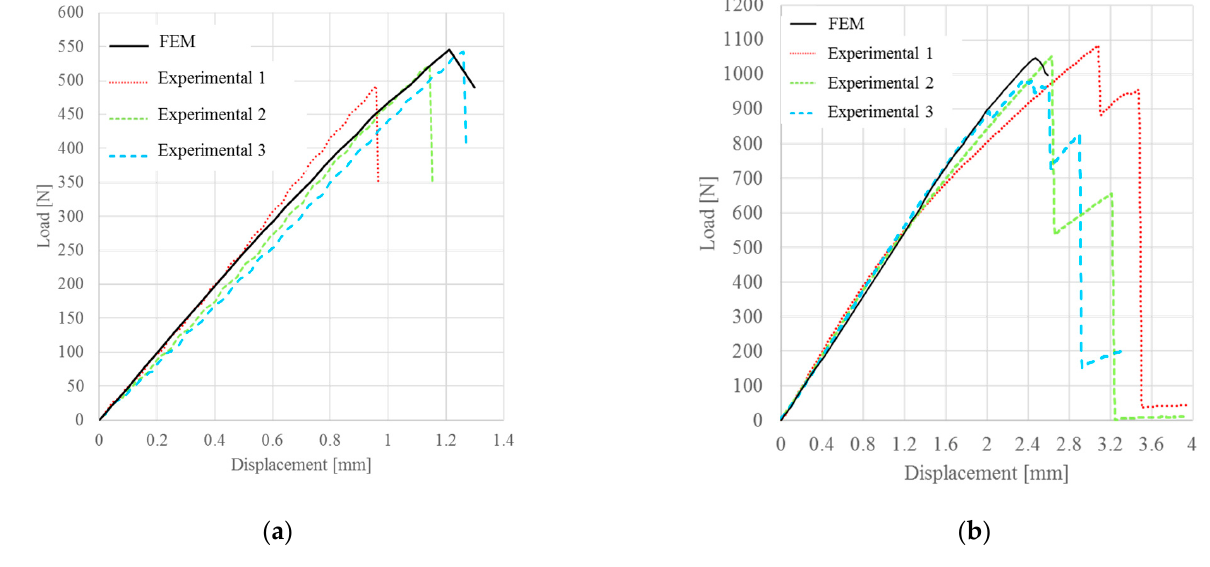
Figure 8. Comparison between experimental and numerical P- δ curve obtained with the bilinear law for: ( a ) untreated specimens; ( b ) 13% treated specimens.